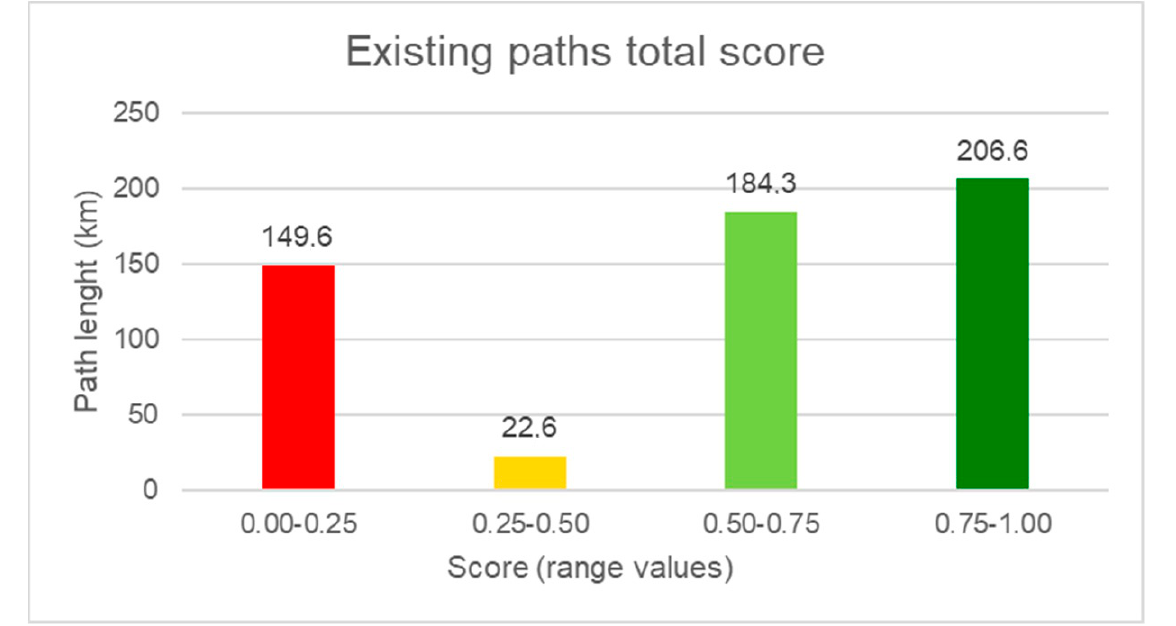
Figure 6. Normalized path value (NPV) of the existing paths. The distribution and interconnection of the paths with a high NPV (>0.75) in the study